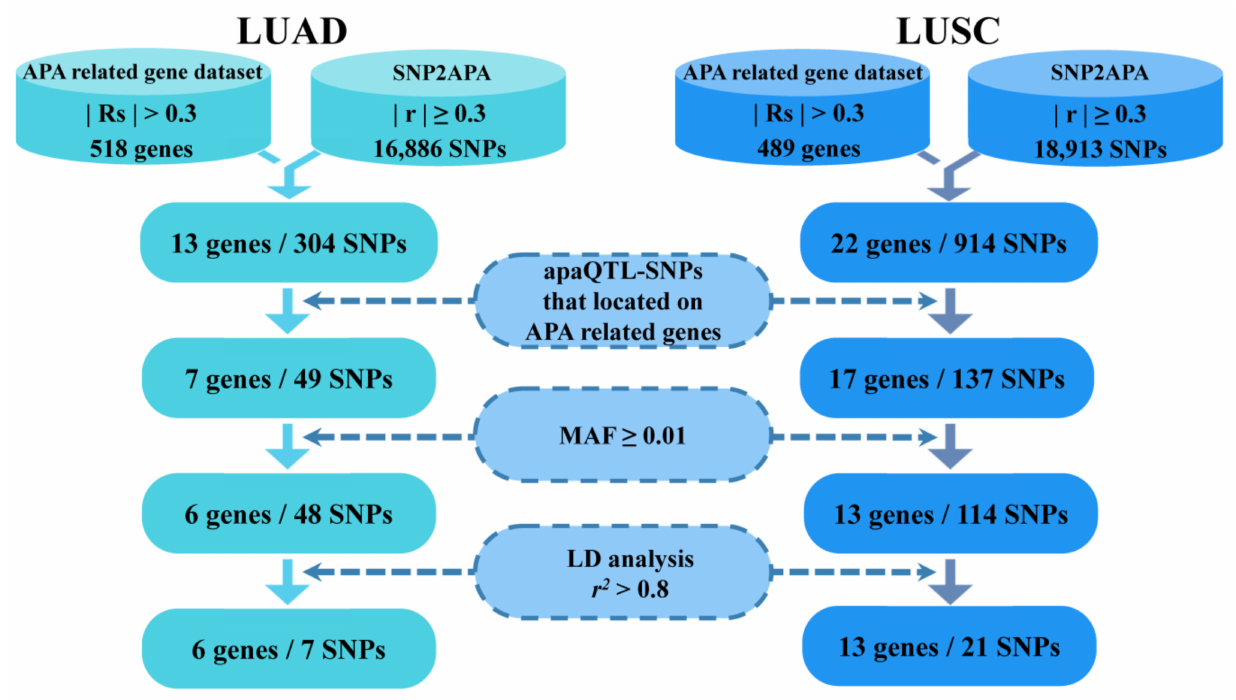
Figure 1. The selection of functional apaQTL-SNPs. apaQTL, alternative polyadenylation quantitative trait loci; SNP, single nucleotide polymorphisms; LUAD, lung adenocarcinoma; LUSC, lung squamous cell carcinoma; RS, Spearman’s correlation; r, correlation coefficient; MAF, minor allele frequency; LD, linkage